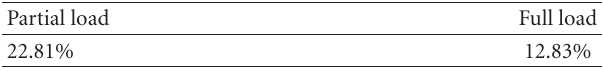
Table 7: HIL results with the fuzzy controller: NSSE%